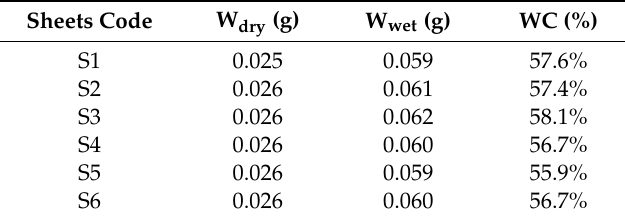
Table 1. Di ff erent water content of each